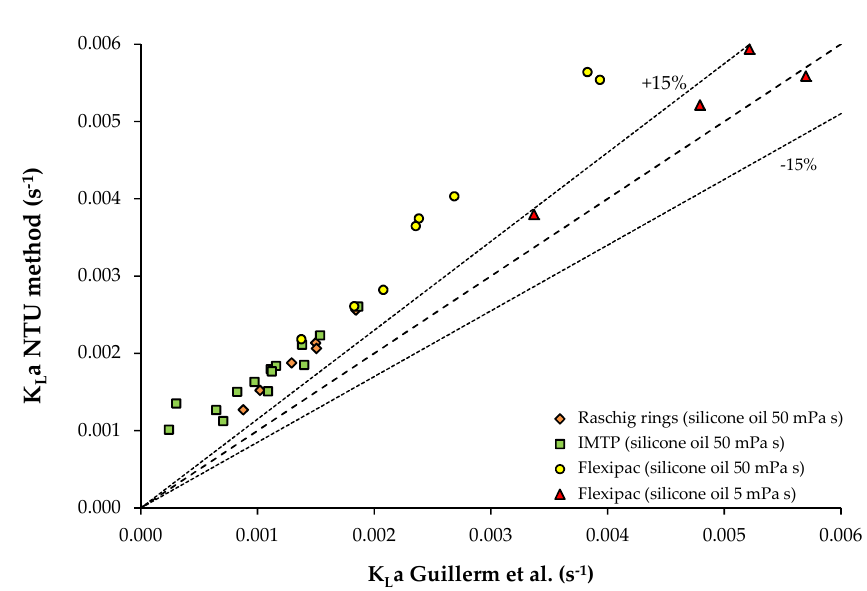
Figure 8. K L a parity plot obtained from the data analysis reported in Reference [10], (V = 1.13 × 10 − 2 m 3 ; T = 25 °C).